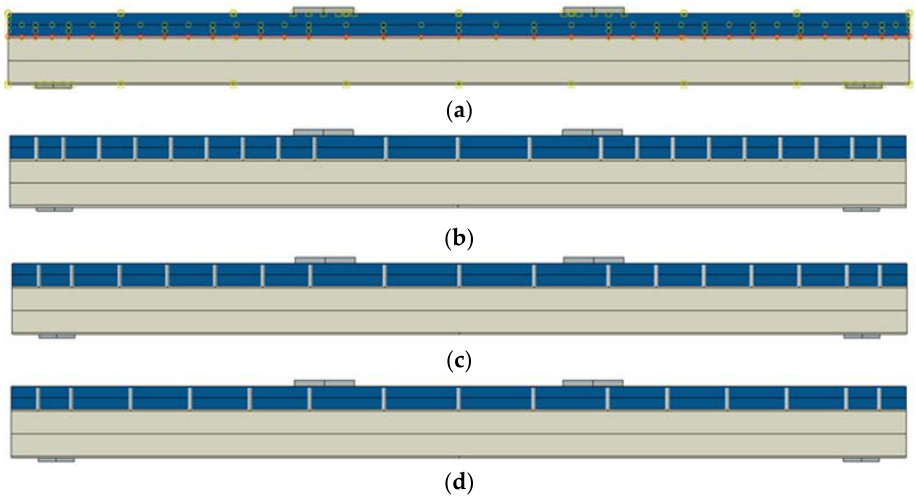
Figure 3. The numerical models: The composite beam with full shear connection ( a ), the B120 beam ( b ), the B160 beam ( c ), the B200 beam ( d ).